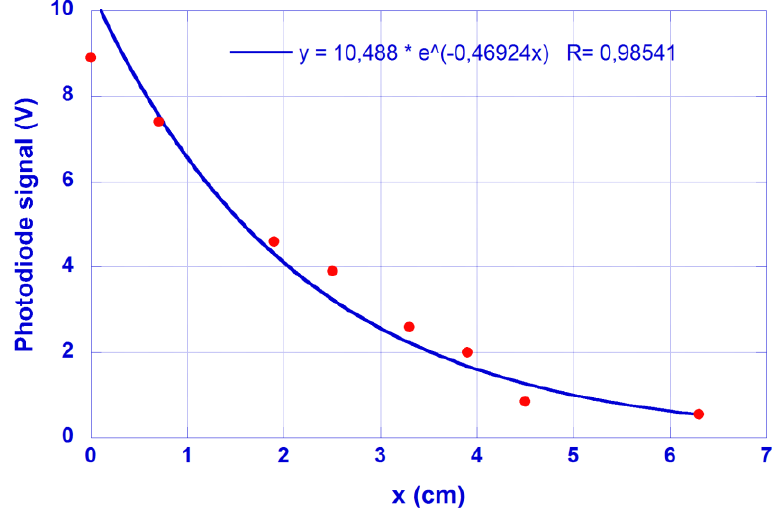
Figure 4. Photodiode signal at the sample output end as a function of its length (x + 4 cm). Feeding laser @ 450 nm. It is a similar sample as employed in the photographic method.